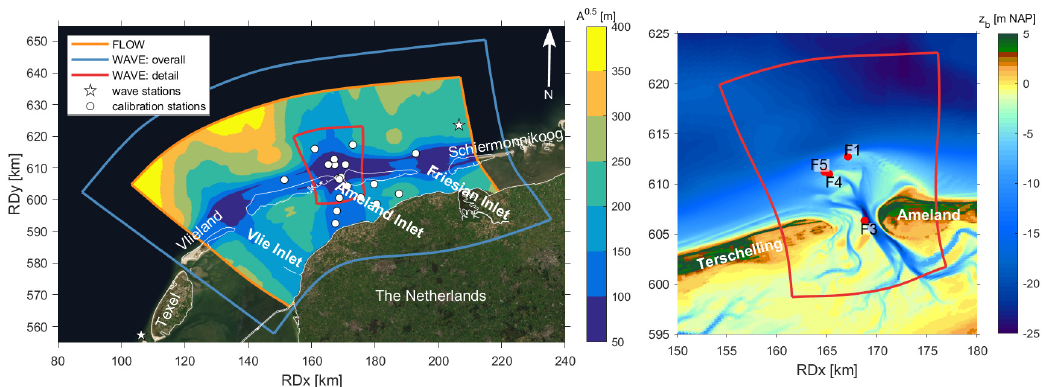
Figure 2. ( Left ): extent of the model grids, including grid cell sizes (given by the square root of the grid cell area A) of the FLOW model. ( Right ): zoom of the model bathymetry at the Ameland Inlet and locations of the measurement frames